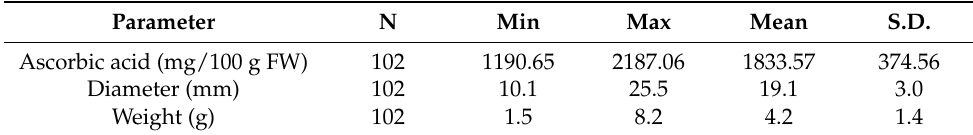
Table 1. Summary of statistics for ascorbic acid content and morphological characteristics (diameter and weight) of acerola fruit.